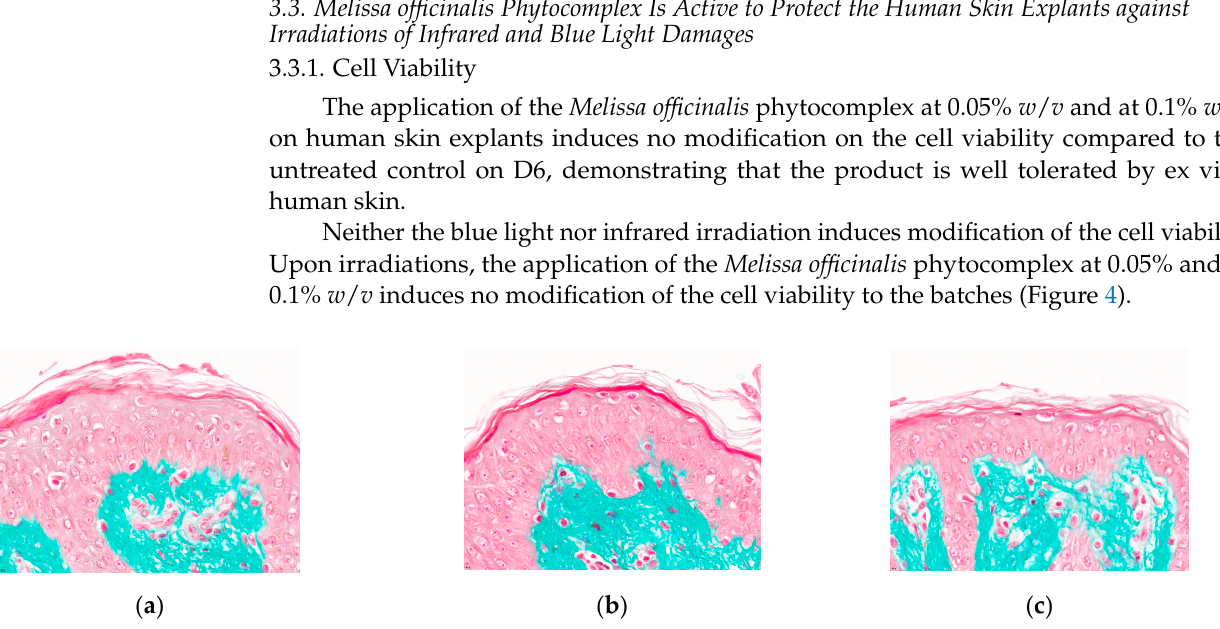
8 of 14 Figure 3. ROS (Radical Oxygen Species) levels in HaCaT cells after 24 h treatment with the Melissa officinalis phytocomplex 0.1% w/v, NAC (N-Acetyl-L-Cysteine) 5 mM and Rutin 0.1% w/v. ROS